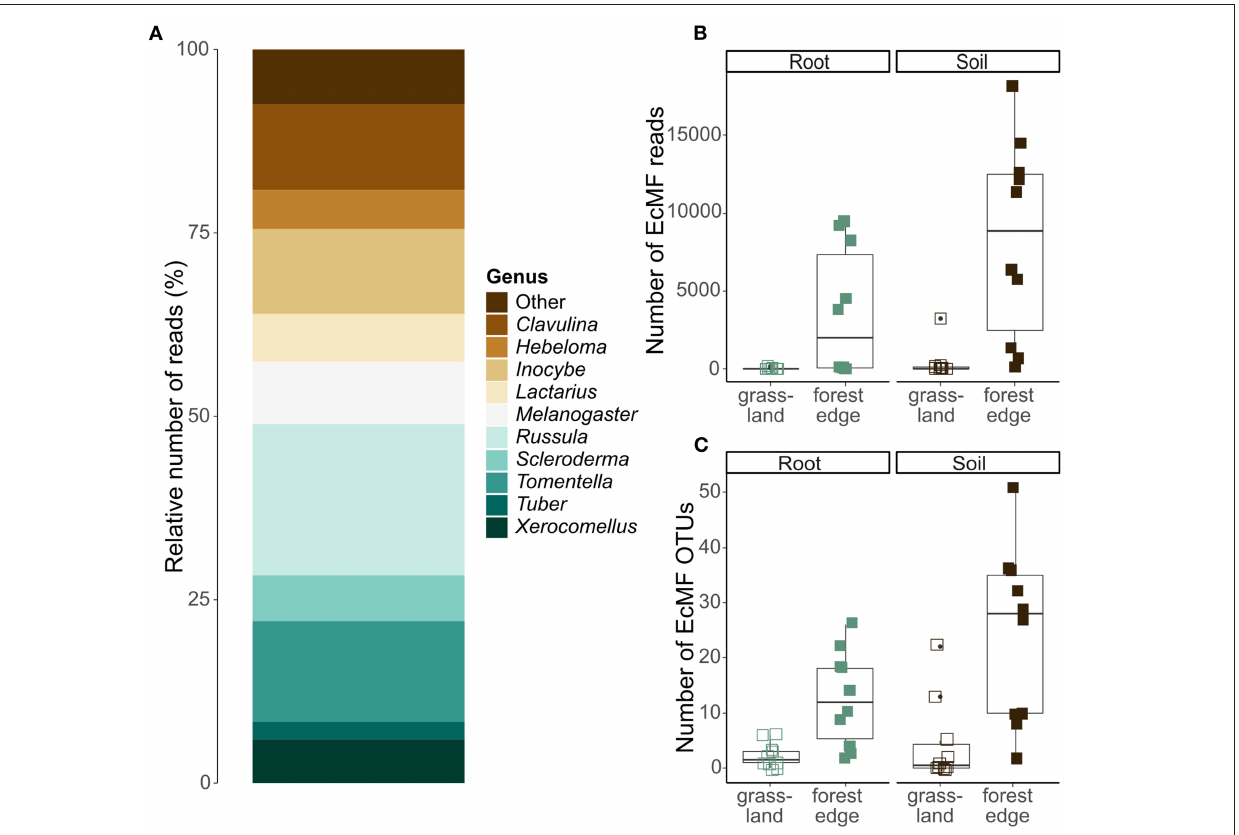
FIGURE 3 | Ectomycorrhizal community composition and OTU diversity in the roots of Crataegus monogyna collected in grassland and forest edge vegetation as determined through metabarcoding with the ITS86F and ITS4 primer pair. (A) Relative number of sequences of EcMF genera. (B) The number of EcMF sequences was significantly higher in the mixed AM + EcM vegetation of the forest edge than in AM-dominated grassland vegetation and in soil samples compared to root samples. (C) The number of EcMF OTUs was significantly higher in samples from the forest edge compared to grassland and in soil samples compared to root